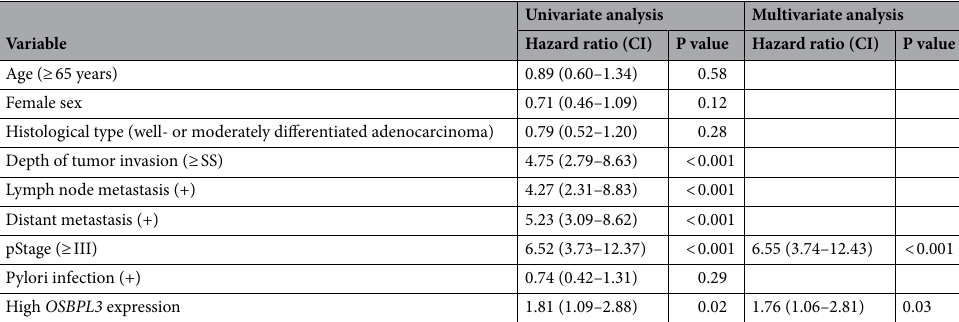
Table 1. Univariate and multivariate analyses of clinicopathological factors affecting the overall survival of patients with gastric cancer from the GSE15459 dataset (n = 192). SS, subserosa; Pylori, helicobacter pylori; pStage, the 6th UICC staging